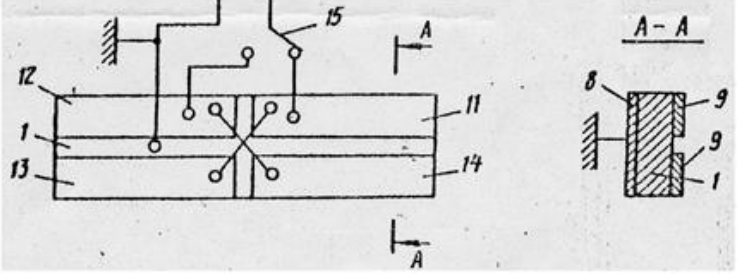
Figure 8. Bidirectional piezoelectric motor designed by Bansiavichus [7].